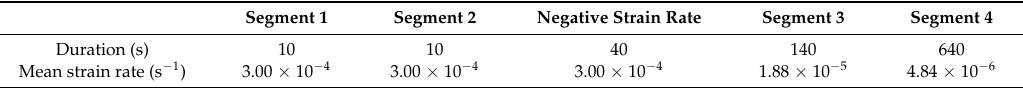
Figure 3. Presentation of the complex signals ( a ) SIS A, ( b ) SIS B, and ( c ) comparison of the two signals with the stress response. Table 2. Description of the five elementary segments composing the SIS A